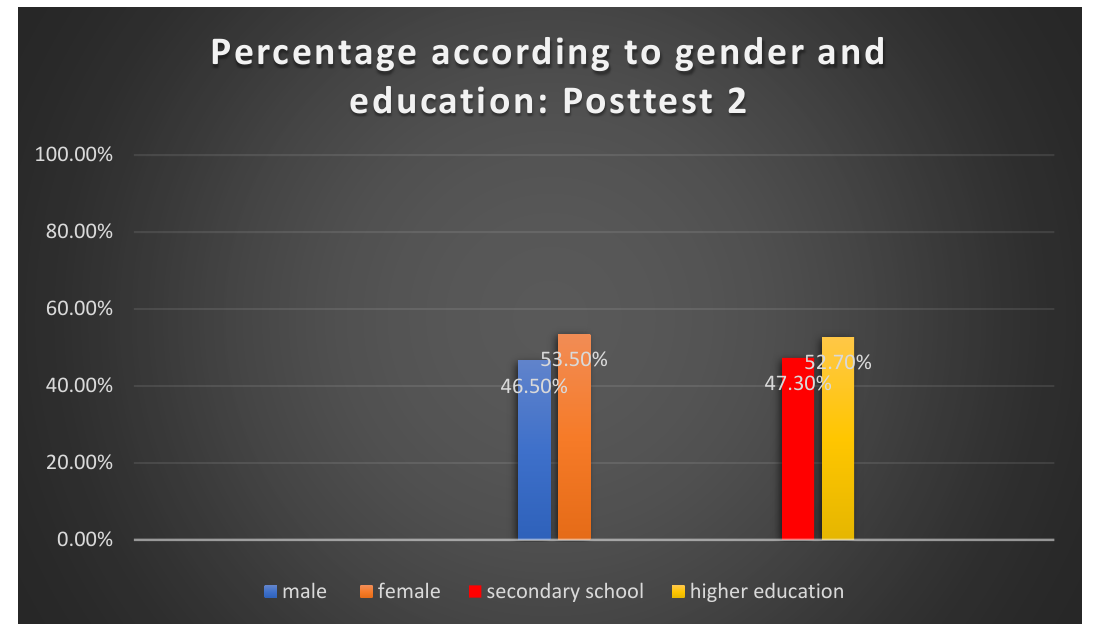
Figure 9. Posttest 2: Percentage of correct answers regarding gender and education.